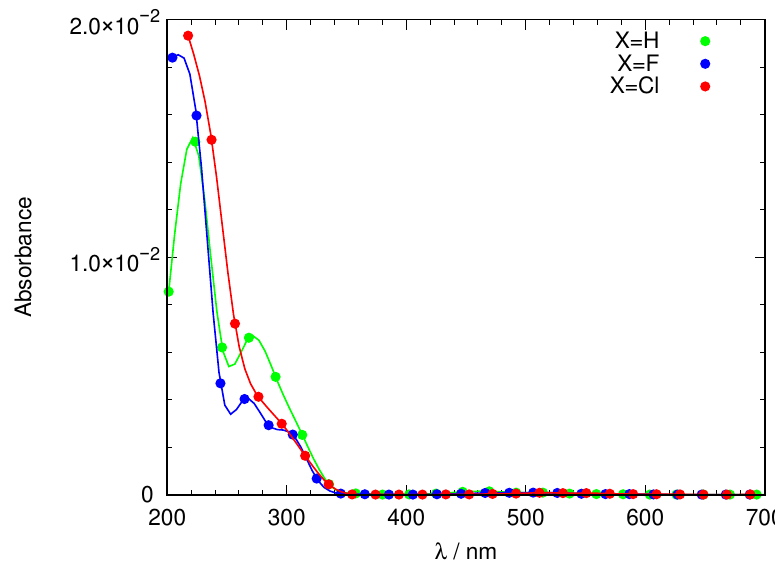
Figure 3. Molecular dynamics simulation of the absorption spectrum of azobenzene derivatives (X=H, F, Cl) using a GAFF2 force-field description of the solute and the solvent. Absorbance is given in arbitrary